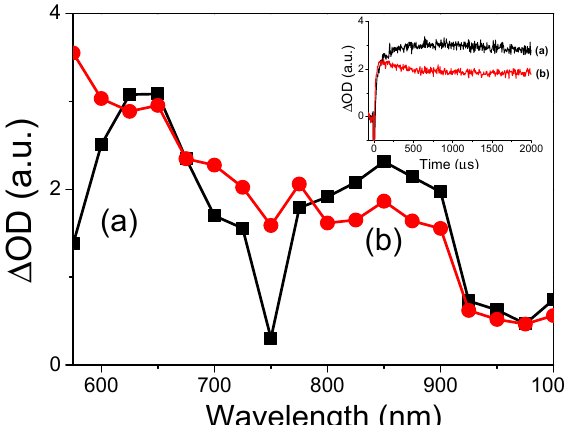
Figure 6. Transient spectra recorded at 100 ( a ) and 1000 µ s ( b ) after 532 nm laser excitation of a N2 purged film of MA 2 CuCl 2 Br 2 . The inset shows the signal profiles monitored at 580 nm ( a ) and 850 nm ( b ).